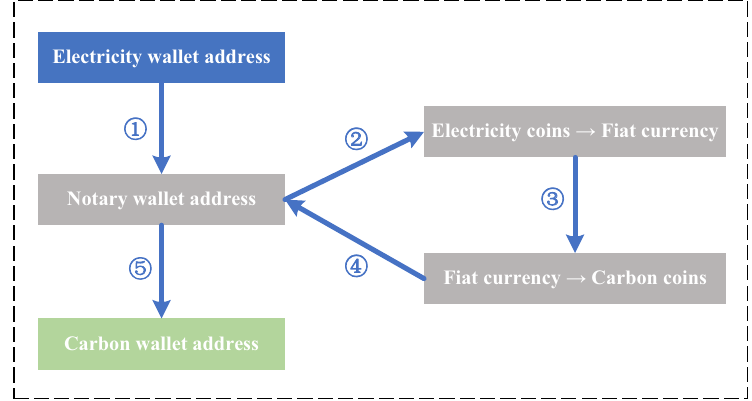
Figure 5. The processes of exchanging electricity coins into carbon coins.